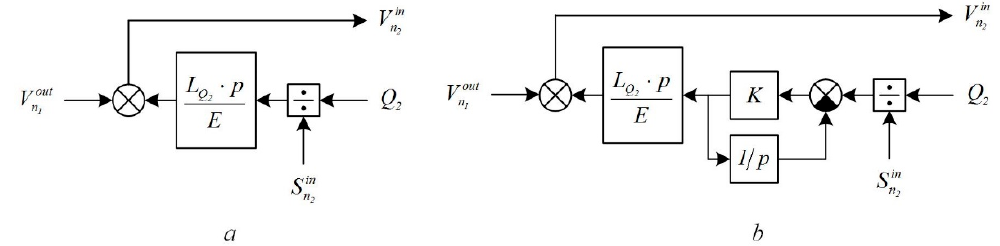
Figure 10. Block diagram of the mathematical model of the inter-stand space in front of the idle stand: ( a ) with the differentiating link; ( b ) without the differentiating link.